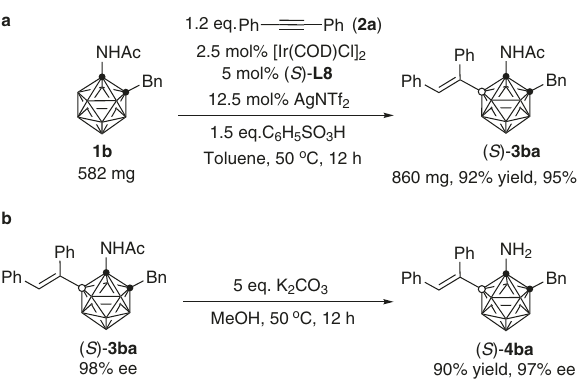
Fig. 5 Large-scale synthesis of ( S )-3ba and its transformation. a Large- scale synthesis of ( S )- 3ba . b Deacylation of ( S )- 3ba .